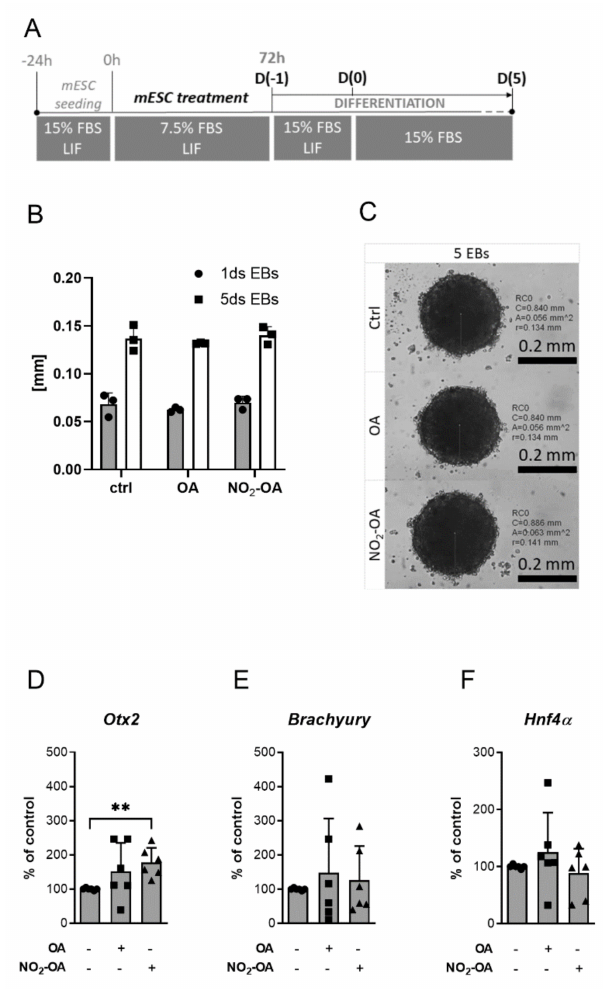
Figure 3. The differentiation process of mESC is changed by NO 2 -OA treatment. ( A ) Time-scheme of the mESC treatment and mESC differentiation protocol used in this experiment. ( B ) The size of embryonic bodies (EBs) was determined on day 1 and day 5 using light microscopy. Data passed Shapiro-Wilk test for normal distribution. Results are expressed as means and standard deviation from three independent experiments (all performed in triplicates). ( C ) Representative microscopic images of EB sizes determined at day 5; circuit—C, content—A, and radius—r. ( C – E ) The mRNA levels of ( D ) ectoderm marker orthodenticle homolog 2 ( Otx2 ), ( E ) mesoderm marker Brachyury , and ( F ) endoderm marker hepatic nuclear factor 4 α ( Hnf4 α ) were evaluated by real-time quantitative PCR analysis in 5 days mESC-derived embryoid bodies (EBs). mESC were incubated for 72 h in medium + leukemia inhibitory factor (LIF) + 7.5% FBS, treated with NO 2 -OA or OA (10 µ M), and further differentiated using EBs-formation protocol. Data are expressed as means and standard deviation from six independent experiments. All statistical significance was determined by unpaired student’s t -test; statistical differences compared to non-treated control were analyzed, ** p <